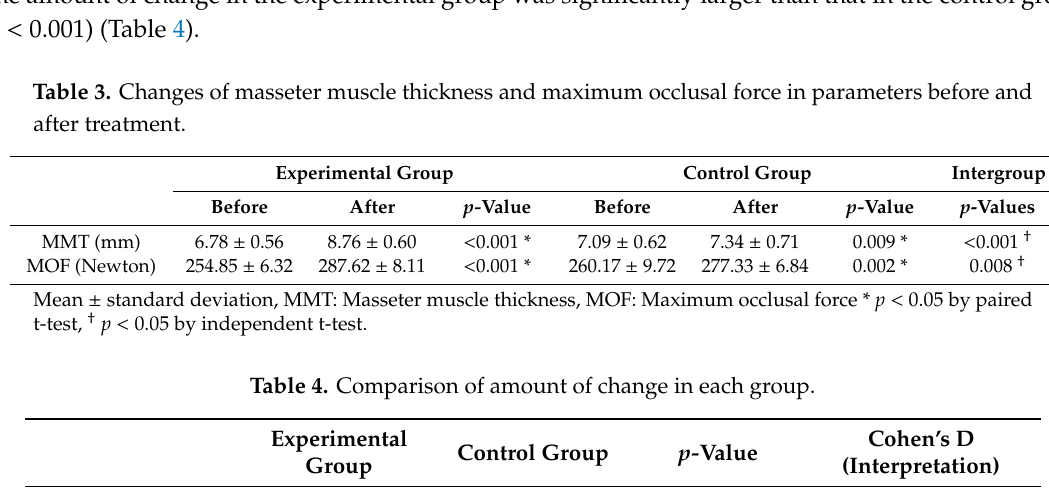
Cohen’s D (Interpretation)